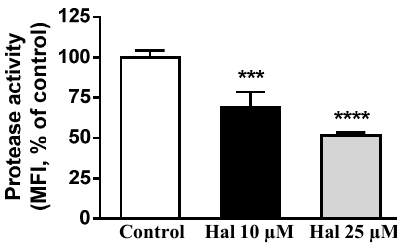
Figure 3. Haloperidol decreases the activity of lysosomal proteases. THP-1 macrophages cells incubated in lipoprotein-deficient serum (LPDS) medium with LDL were kept untreated (control) or treated with haloperidol (10 and 25 µM) for 30 min, then DQ-BSA was added for 30 min and analyzed by flow cytometry. Results are mean ± SEM of three independent experiments. MFI, median fluorescence intensity. Statistical comparisons shown are haloperidol versus control (*** p < 0.001 and **** p < 0.0001).